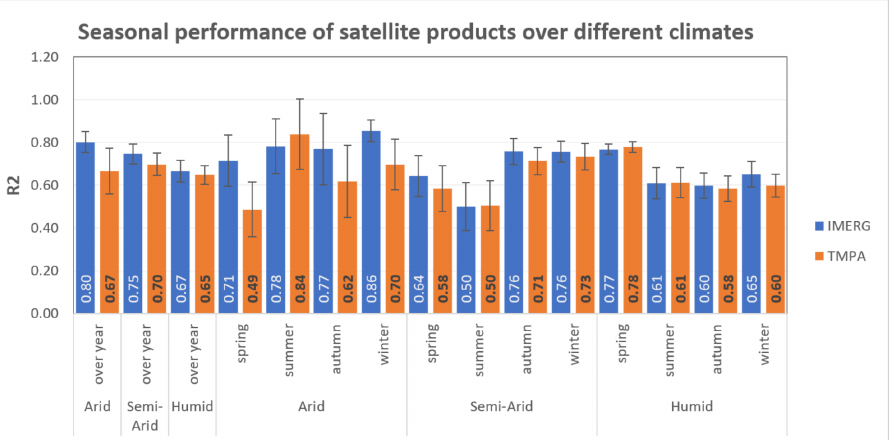
Figure 10. Average seasonal performance of IMERG and TMPA data and their standard errors.